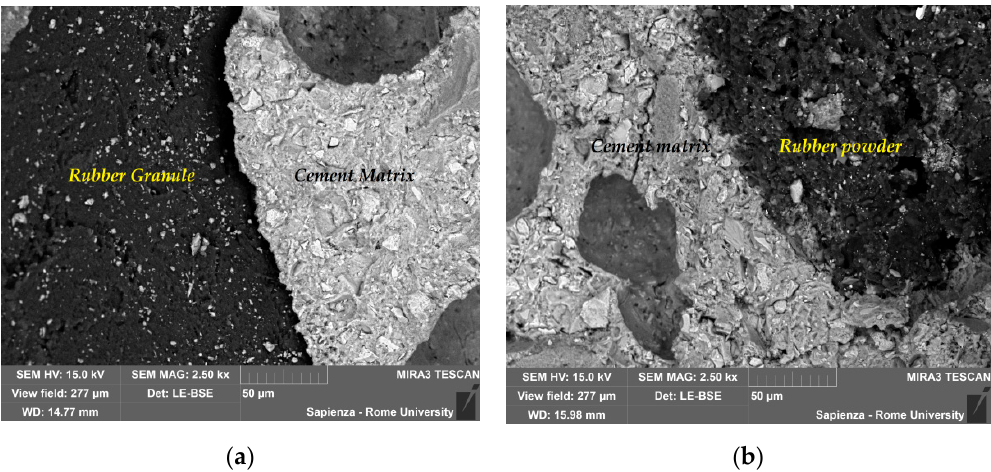
Figure 6. SEM micrograph of rubber fillers-cement matrix interface: rubber granule–cement adhesion ( a ) and rubber powder-cement adhesion ( b ) .